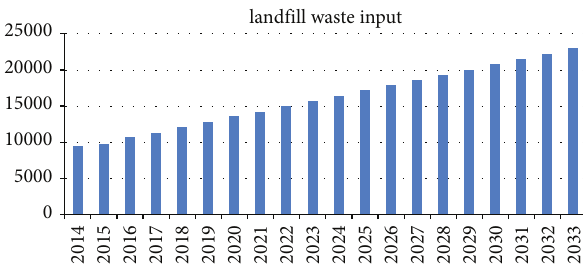
Figure 2: The result of estimating the amount of waste generated in EViews software analysis as a graph. Table 5: Total quantities of gas and methane gas in the landfill